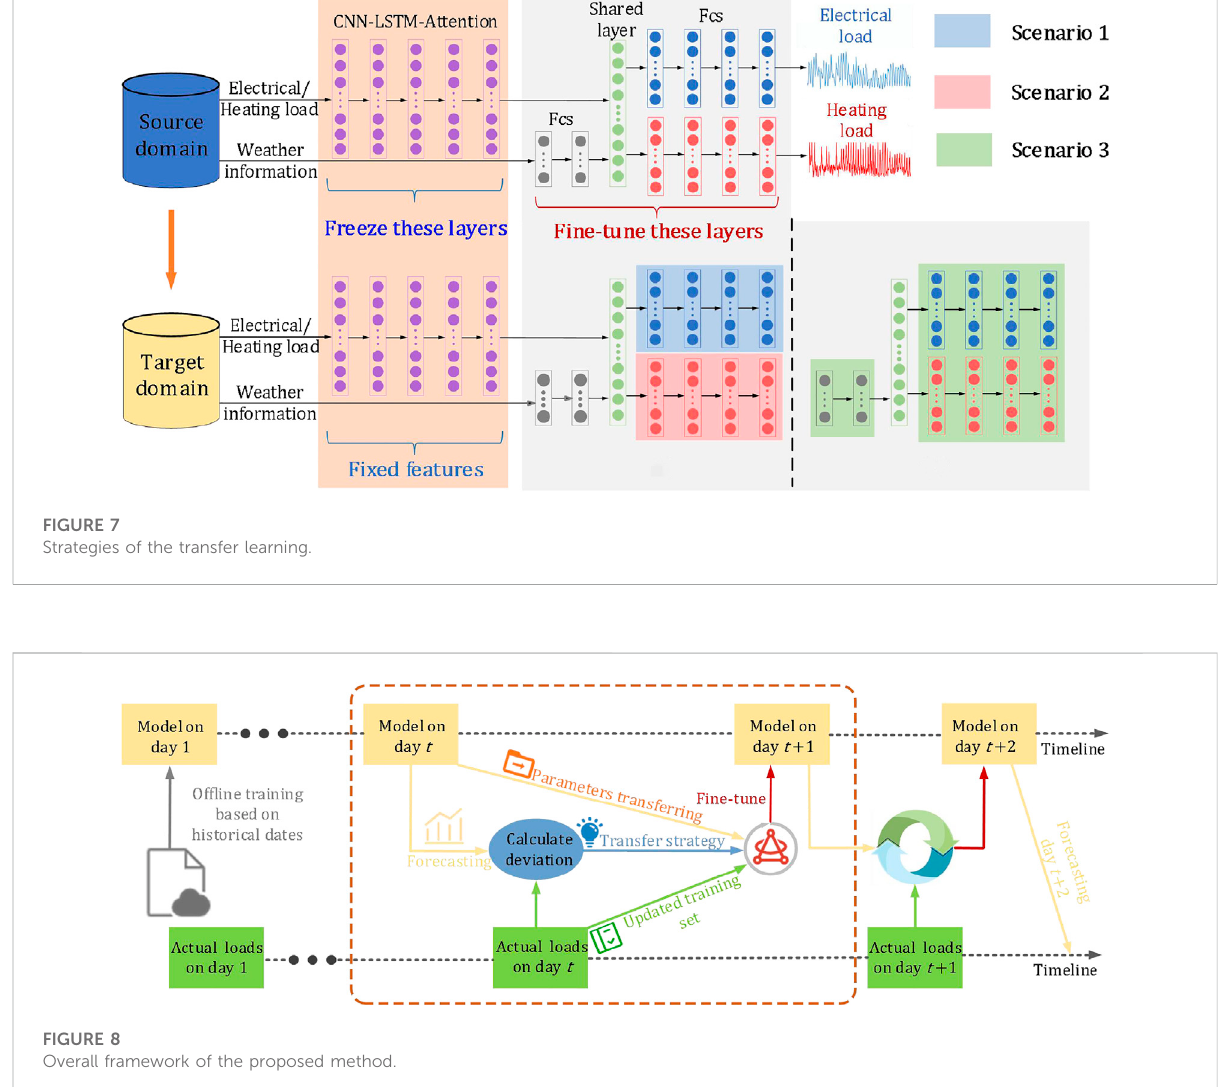
FIGURE 8 Overall framework of the proposed